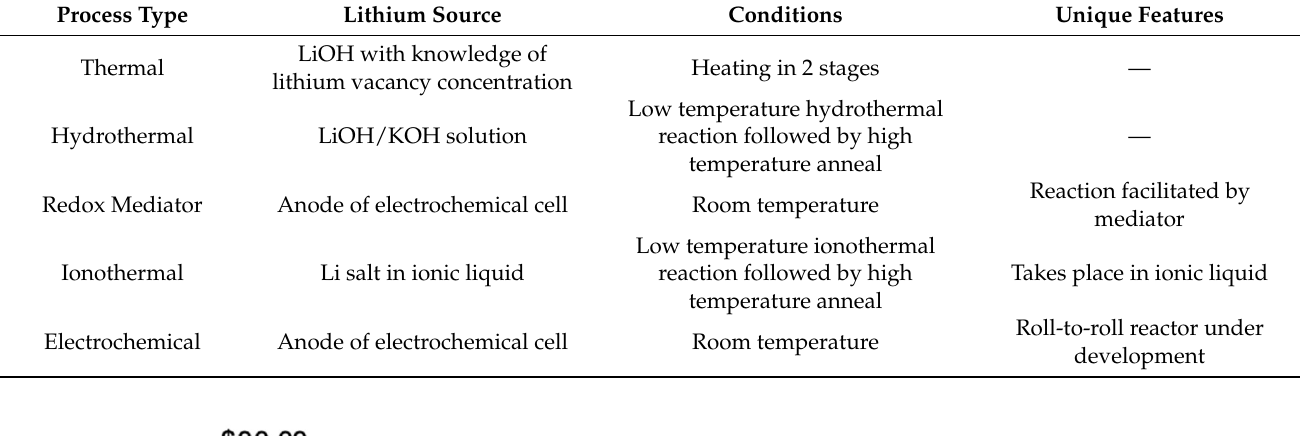
Table 1. Comparison of relithiation process characteristics.